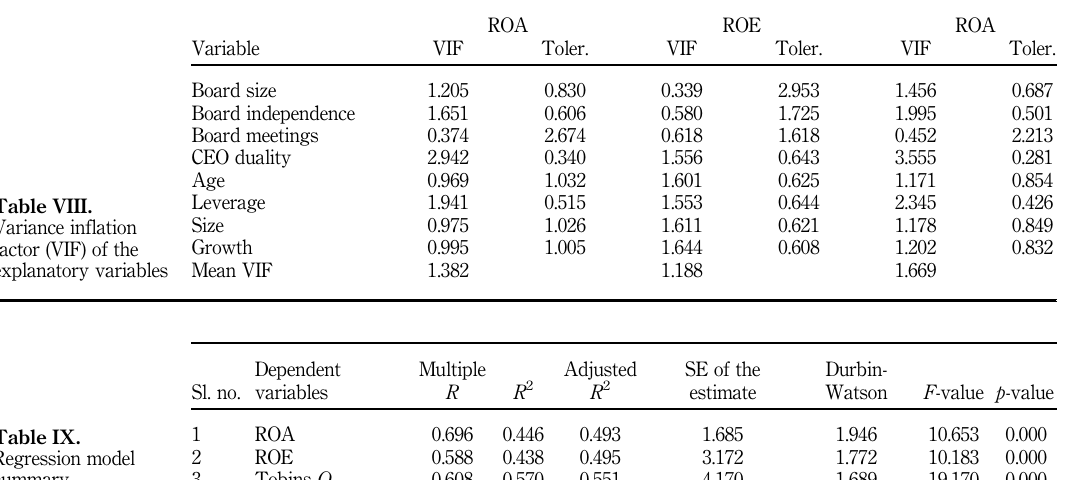
Table IX. Regression model